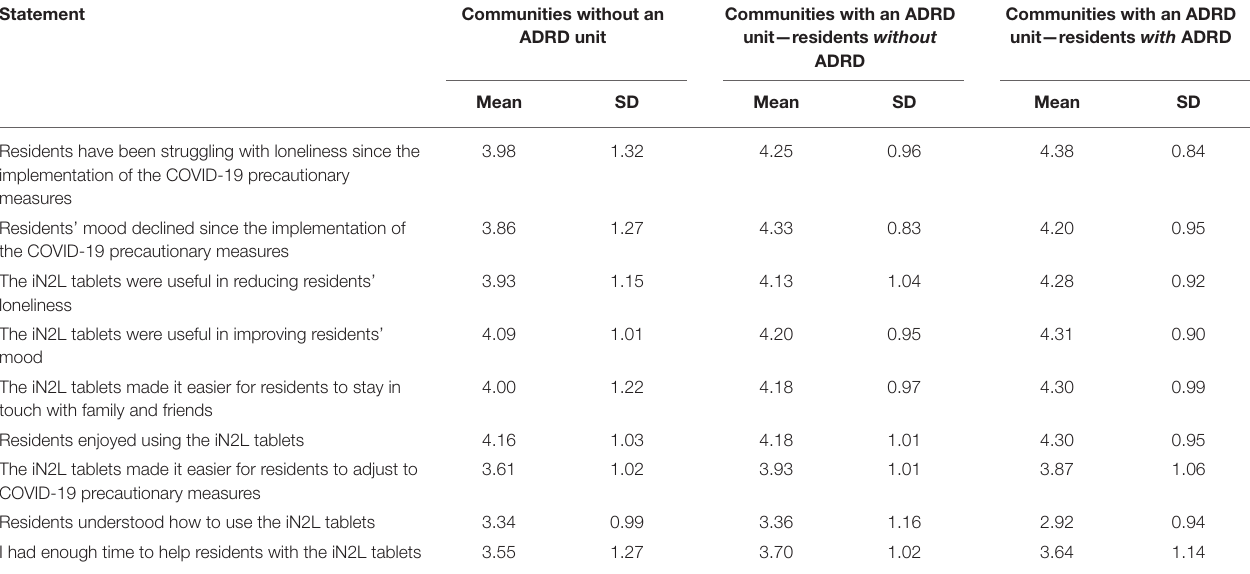
TABLE 1 | Staff perceptions on mood, loneliness, and tablet use (on a scale from 1 “strongly disagree” to 5 “strongly agree”).